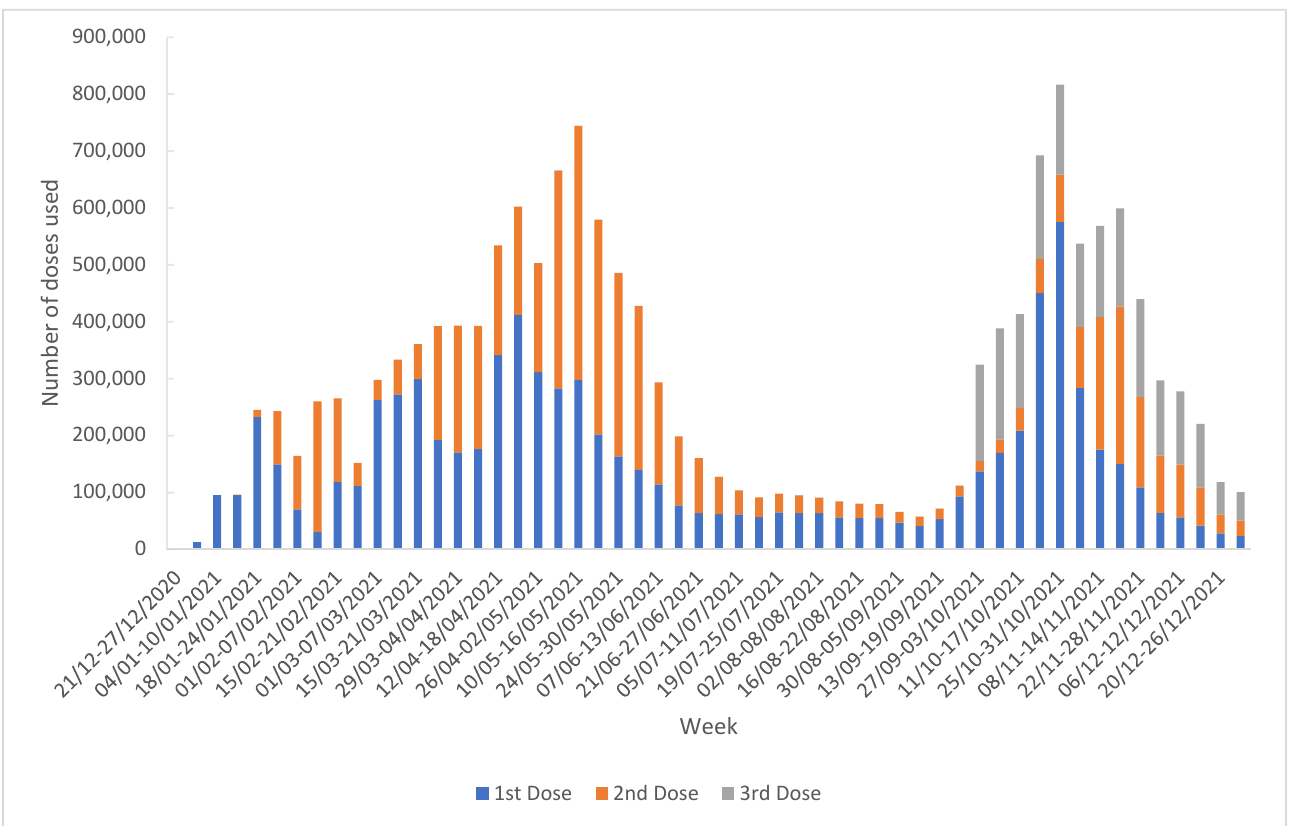
Figure 2. The weekly evolution of the COVID-19 vaccination campaign, Romania, 27 December 2020–31 December